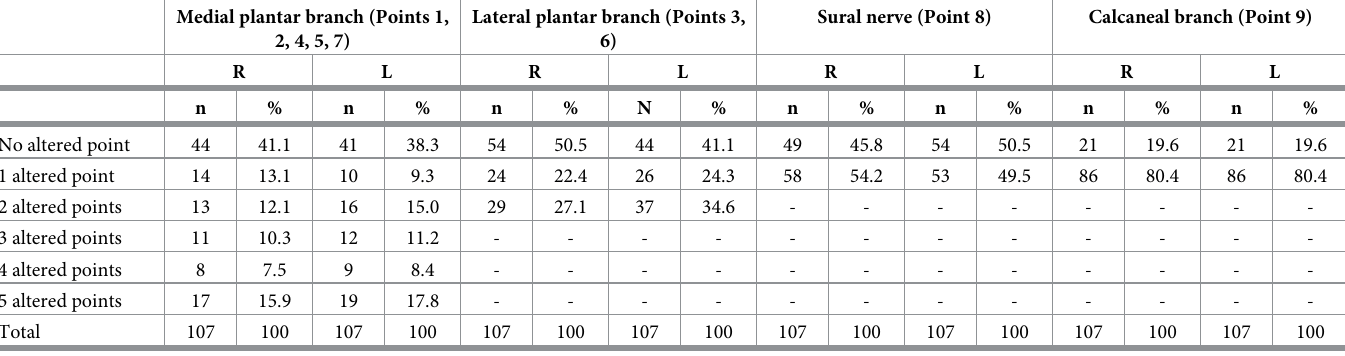
Table 9. Distribution of the number of SWM-test (normal and altered) points of the feet per patient at the treatment diagnosis and corresponding nerves. Medial plantar branch (Points 1, 2, 4, 5,